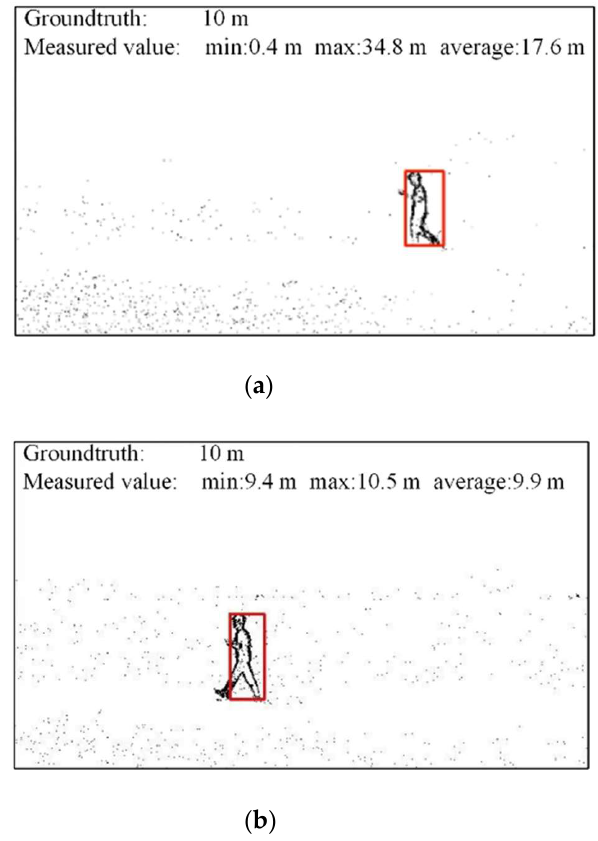
Figure 17. Comparison of distance measurement results by PnP and similar triangle. ( a ) PnP distance measurement, ( b ) similar triangle distance measurement. Table 6. Results of PnP and similar triangle distance measurement methods.